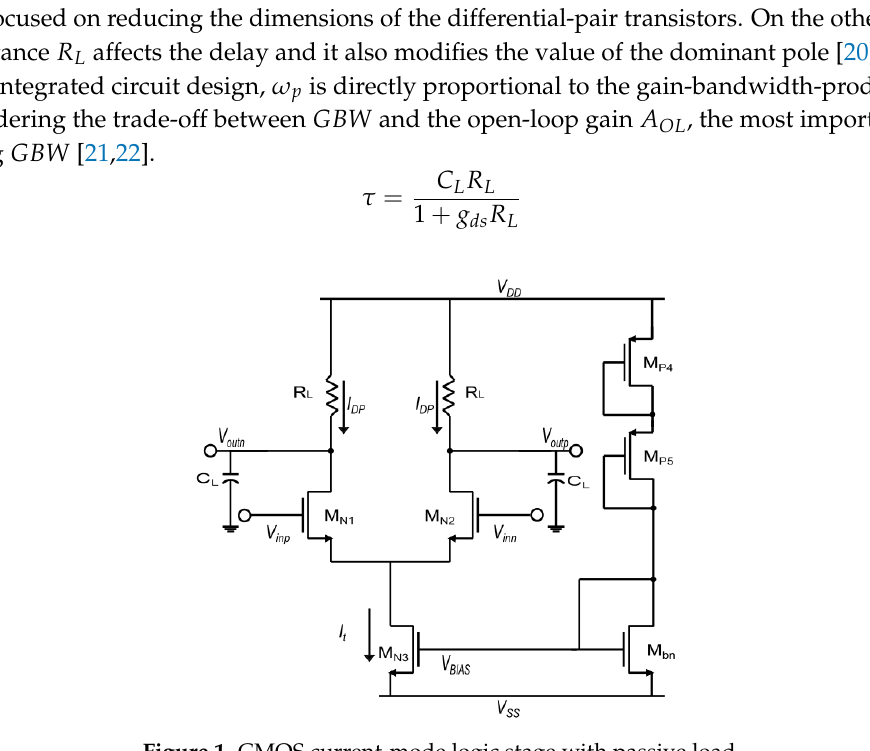
Figure 1. CMOS current-mode logic stage with passive